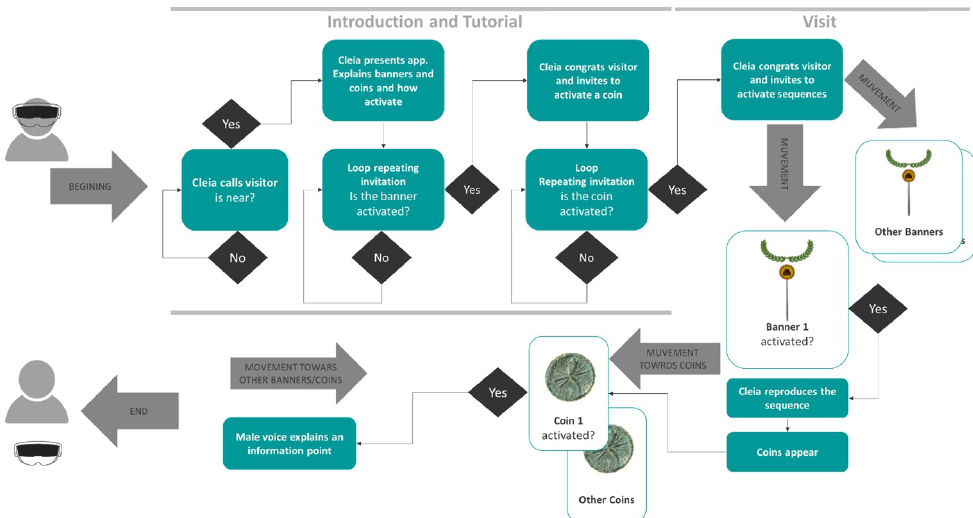
Figure 3. Interaction